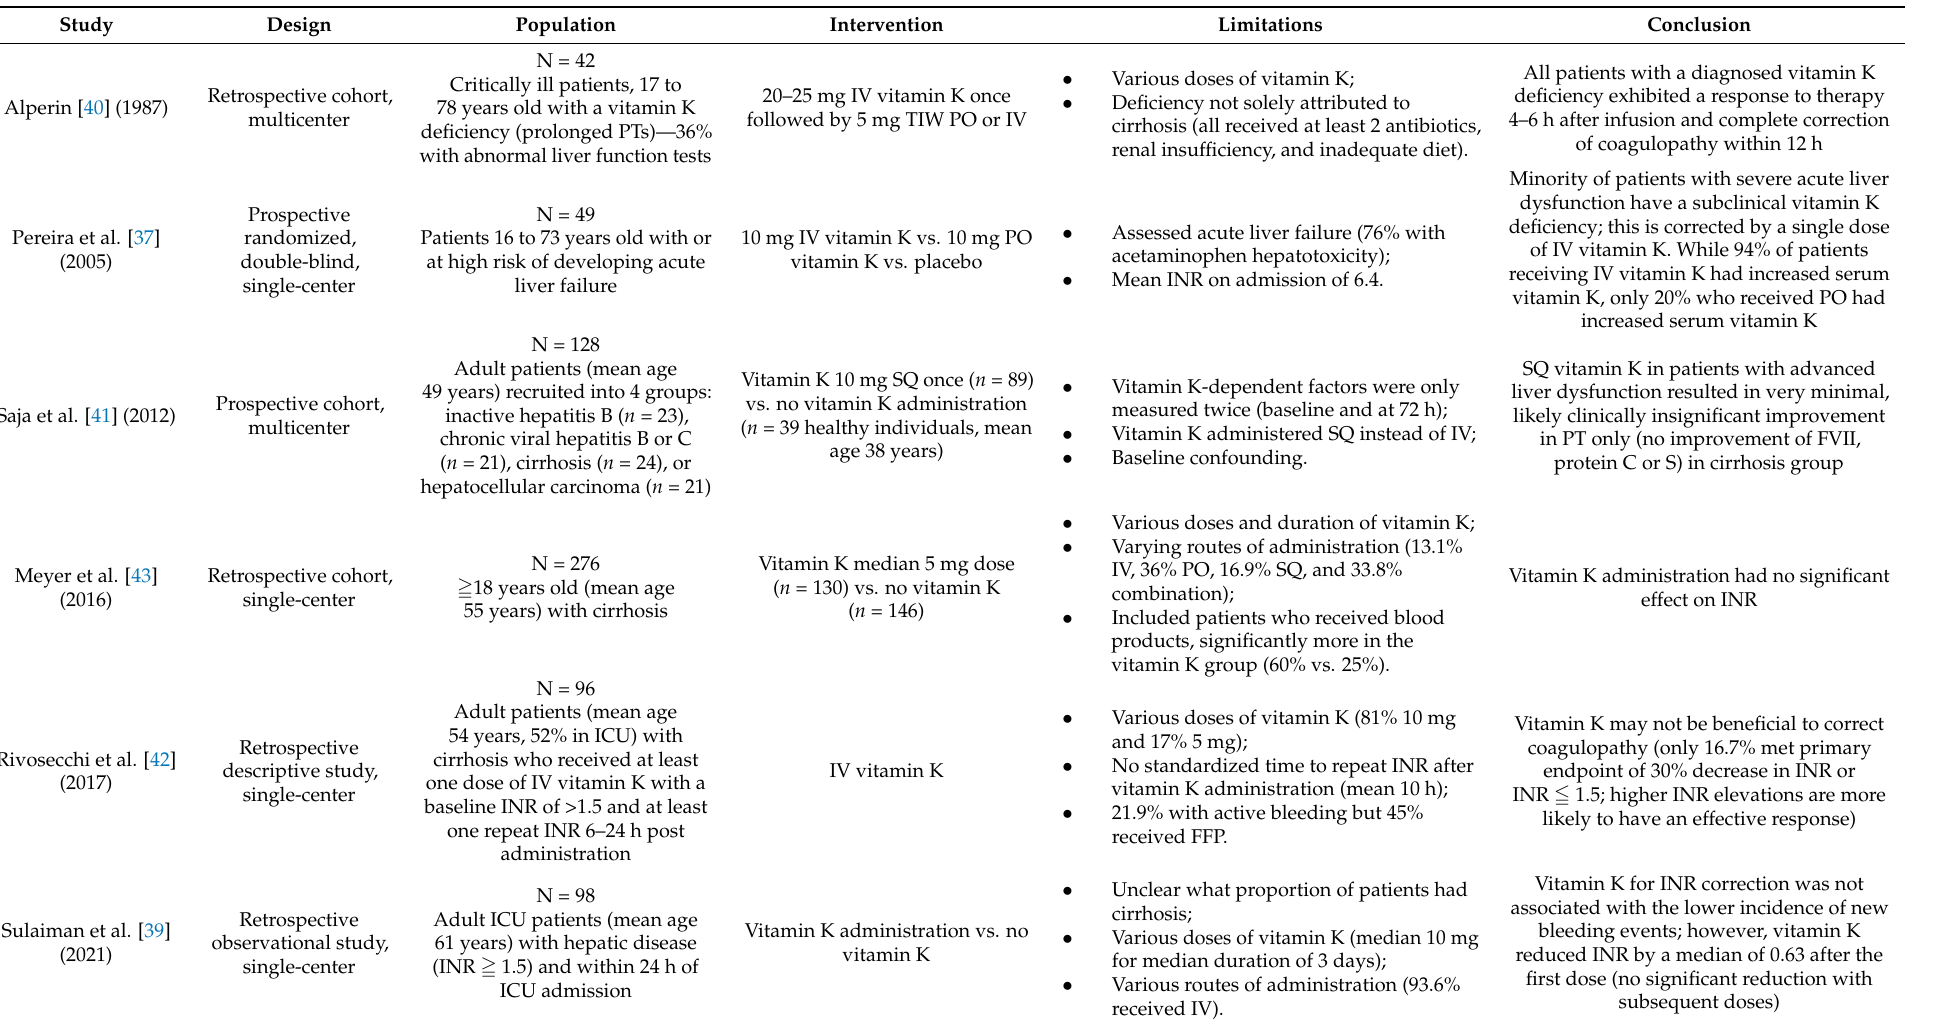
Table 1. Studies evaluating the use of vitamin